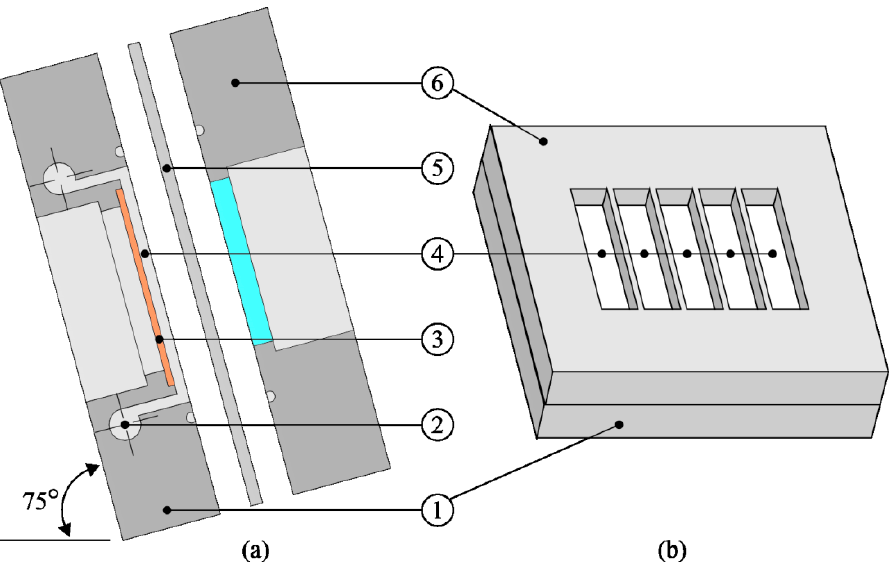
Figure 2. The test section: ( a ) cross-section, ( b ) front view, 1—front cover, 2—mini-channel mani- fold, 3—glass plate, 4—mini-channel, 5—heated plate, 6—channel body. 3—glass plate, 4—mini-channel, 5—heated plate, 6—channel